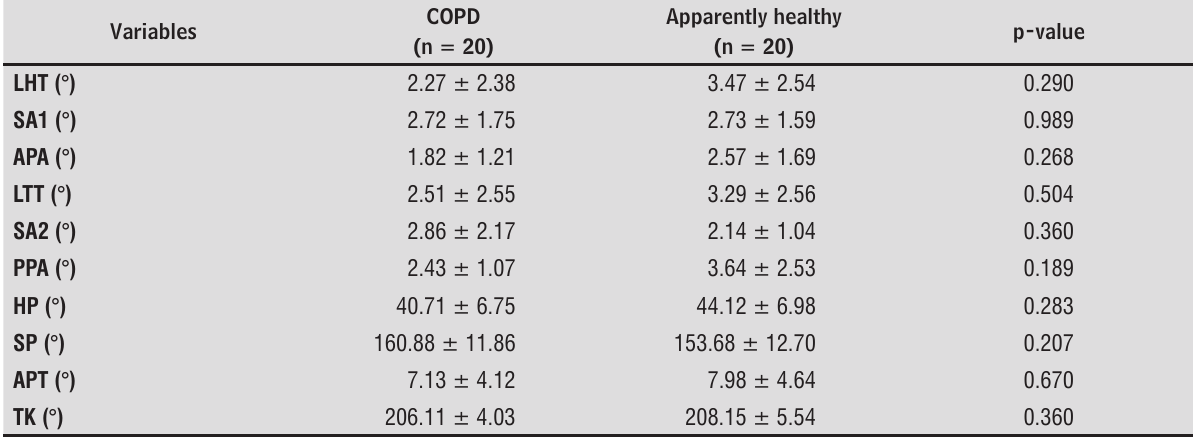
Table 3 – Comparison of postural alignment between men and women in the COPD group (n = 20)